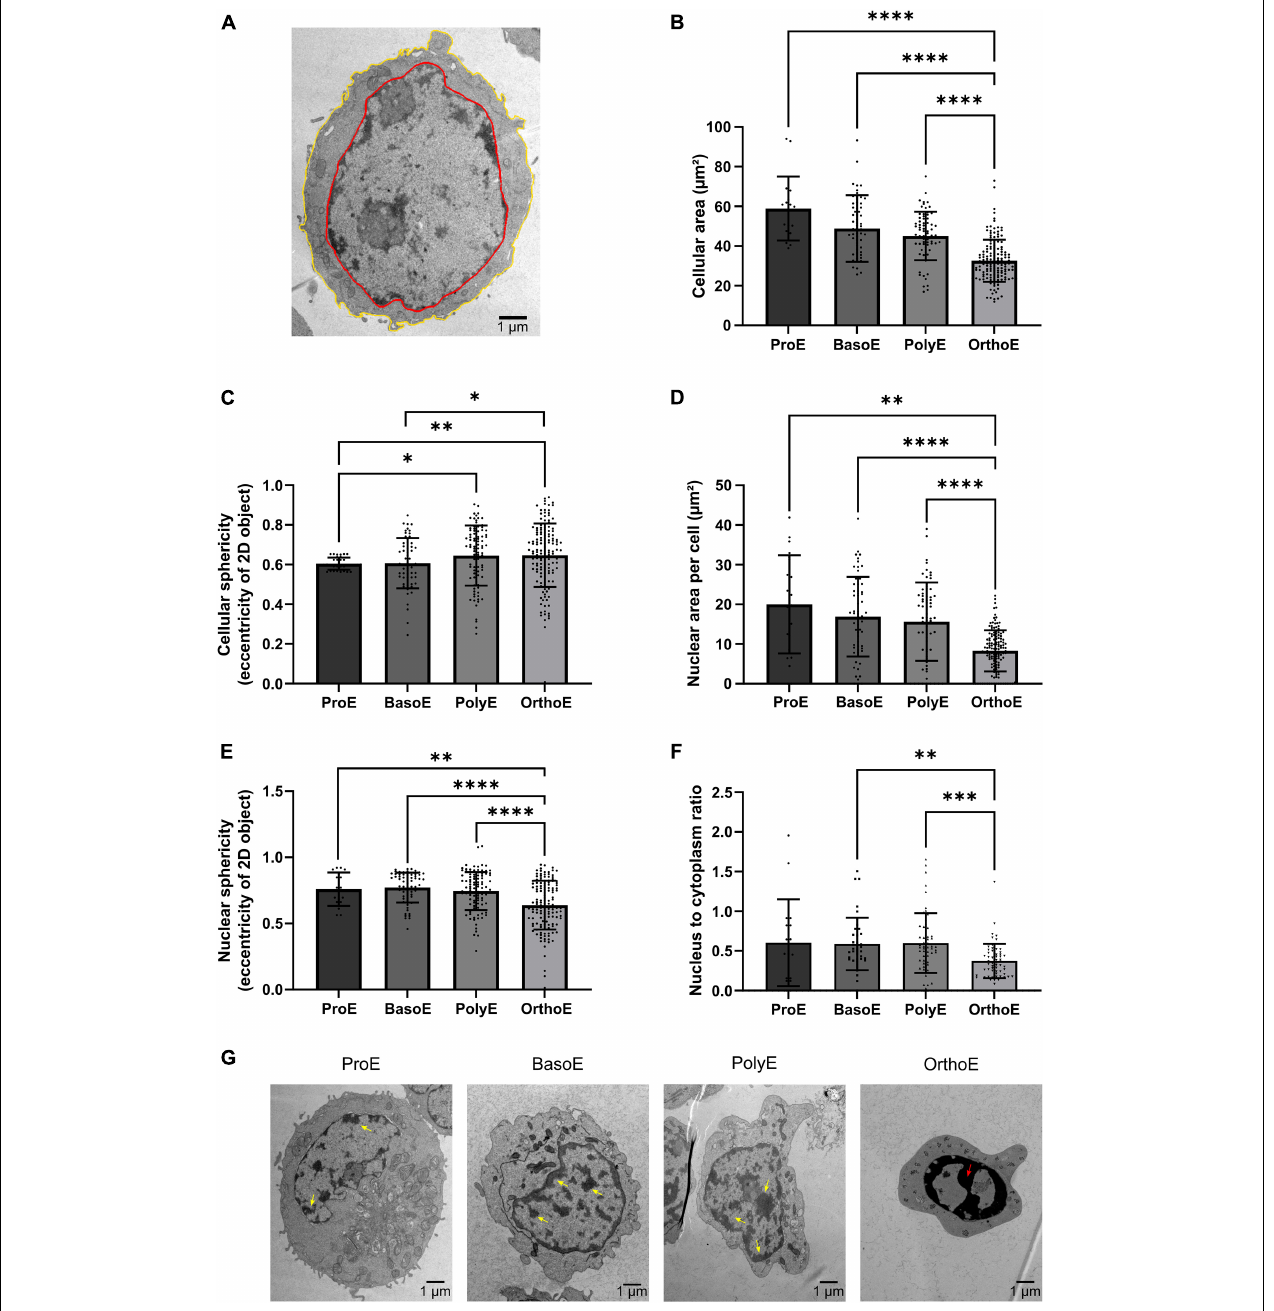
FIGURE 2 | Cellular and nuclear characteristics of erythroblasts. (A) 3DMOD-based drawing of cellular (yellow) and nucleus (red) rims on a ProE permitting area quantification from 2D section. (B,C) Quantification of cellular area (B) and eccentricity (C) of erythroblasts. (D–F) Quantification of area (D) , eccentricity (E) of nucleus, and ratio of nucleus to cytoplasm area (F) in each of the differentiation stage. (G) Representative images of chromatin condensation from ProE to OrthoE. Yellow arrow: condensed chromatin; red arrow: pyknotic nucleus. Kruskal–Wallis analysis on at least 20 images for the three replicates. ∗ p < 0.05; ∗∗ p < 0.01; ∗∗∗ p < 0.005, ∗∗∗∗ p < 0.001.